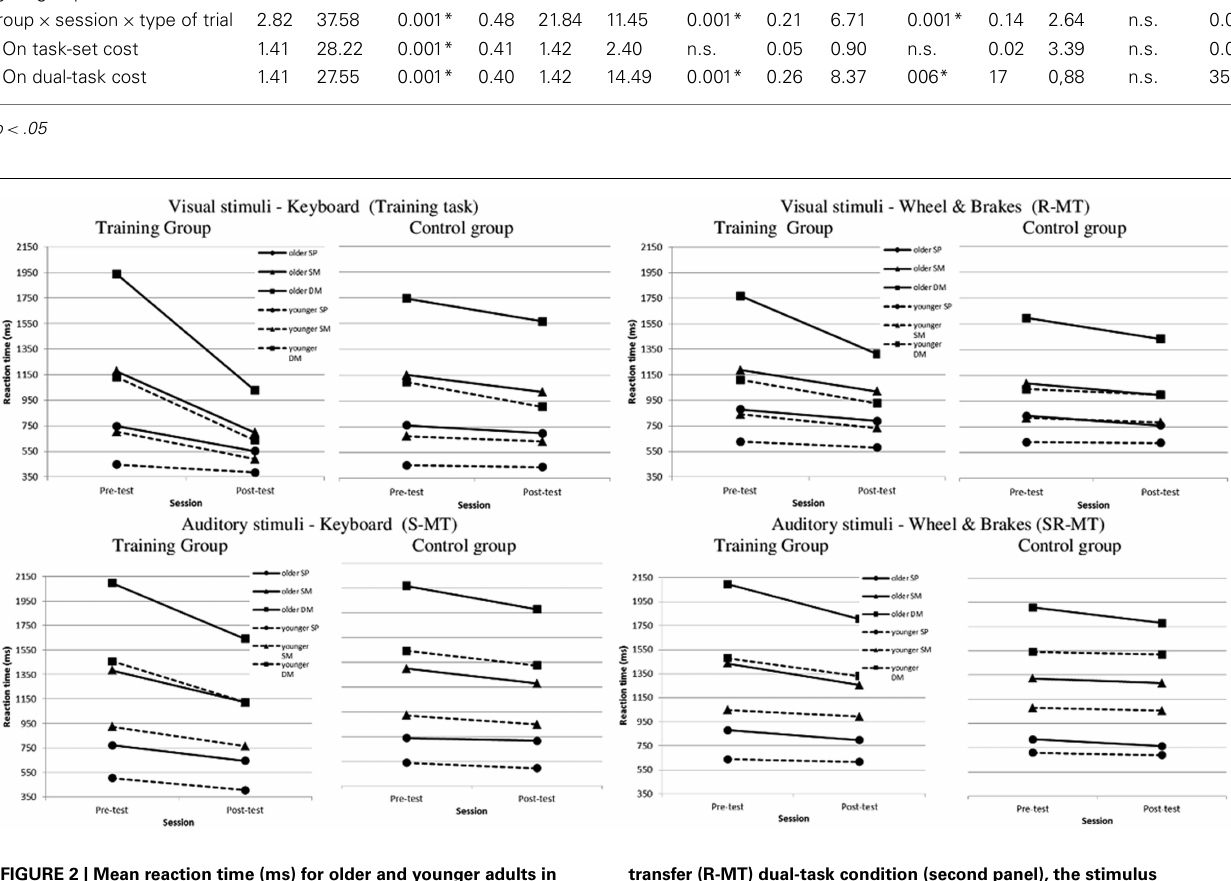
to a greater extent in training group than in control